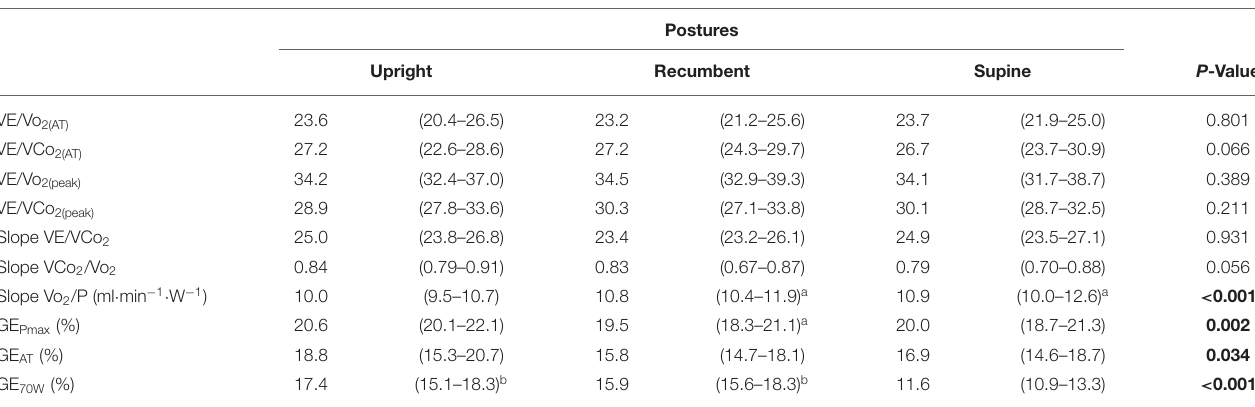
TABLE 3 | Ventilatory and metabolic efficiency in three different cycling